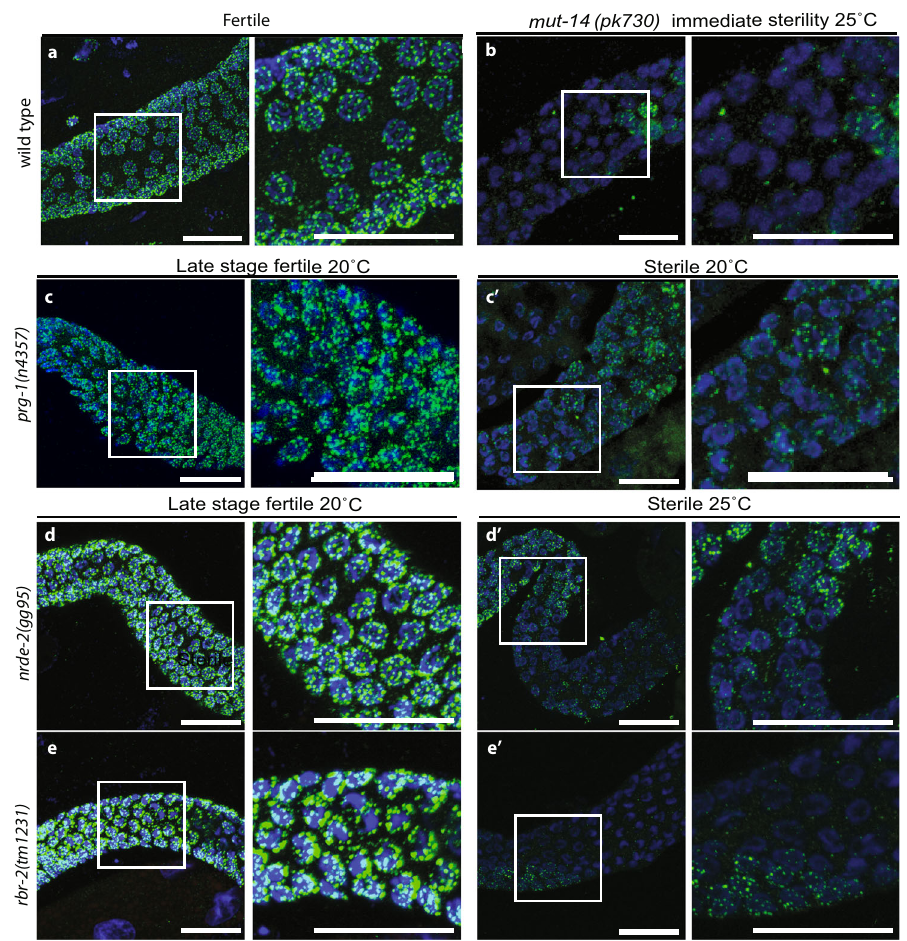
Fig. 2 At sterility, partial loss of P granule staining occurred in prg-1 and temperature-sensitive mutants. Germlines of sterile days 2 – 3 adult animals were stained using the OIC1D4 antibody against PGL-1 in P granules (green) and DAPI (blue). More than fi ve independent OIC1D4 antibody immuno fl uorescence experiments were performed on wild-type and different mutants with similar results and at least fi ve animals were scored for each condition (Table S1). Representative images are shown. Scale bars indicate 20 µ m. a Control animals contain uniform puncta of P granule staining surrounding each nucleus; b mut-14 mutants display an immediate sterility when shifted to 25 °C for one generation and display P granule abnormalities. c – e Late generation fertile prg-1, nrde-2 , and rbr-2 animals displayed relatively normal P granule staining in the germlines; c ʹ – e ʹ prg-1 , nrde-2 , and rbr-2 sterile siblings all exhibited some degree of germ cell P granule